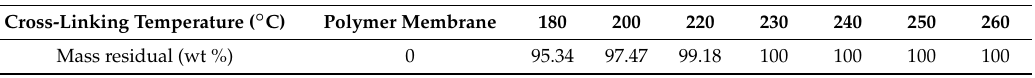
Table 4. The mass residual of PAN and CLA-PAN membranes prepared at different cross-linking temperatures dissolved in DMAc.